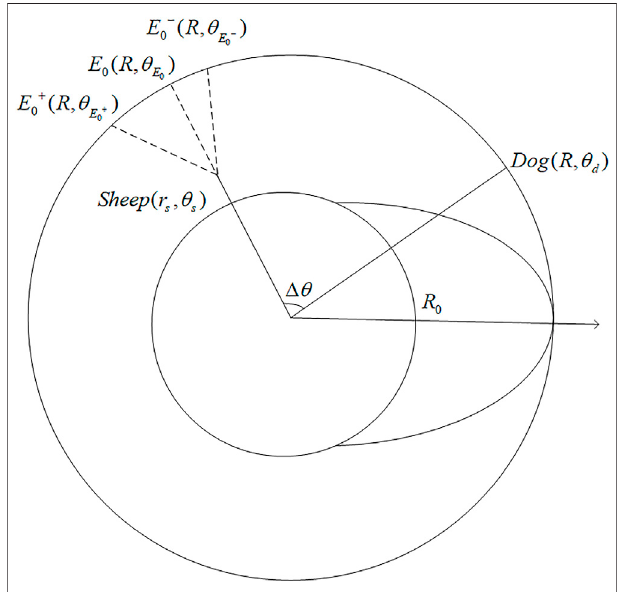
FIGURE 3 | Diagram of evasion strategy for sheep located in M r \ M 1